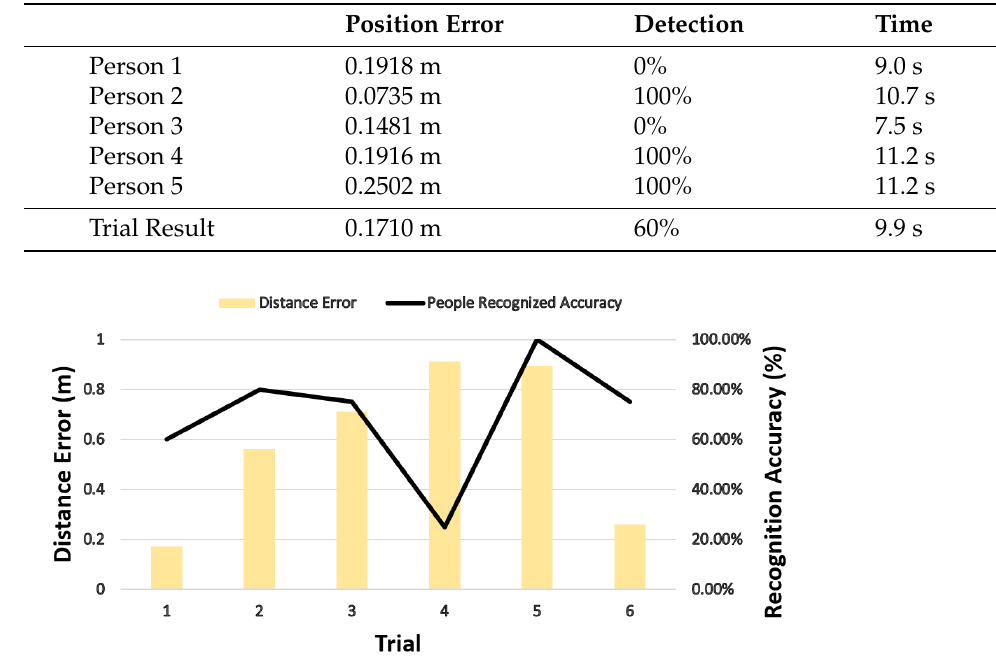
Figure 14. People Perception FBM results per